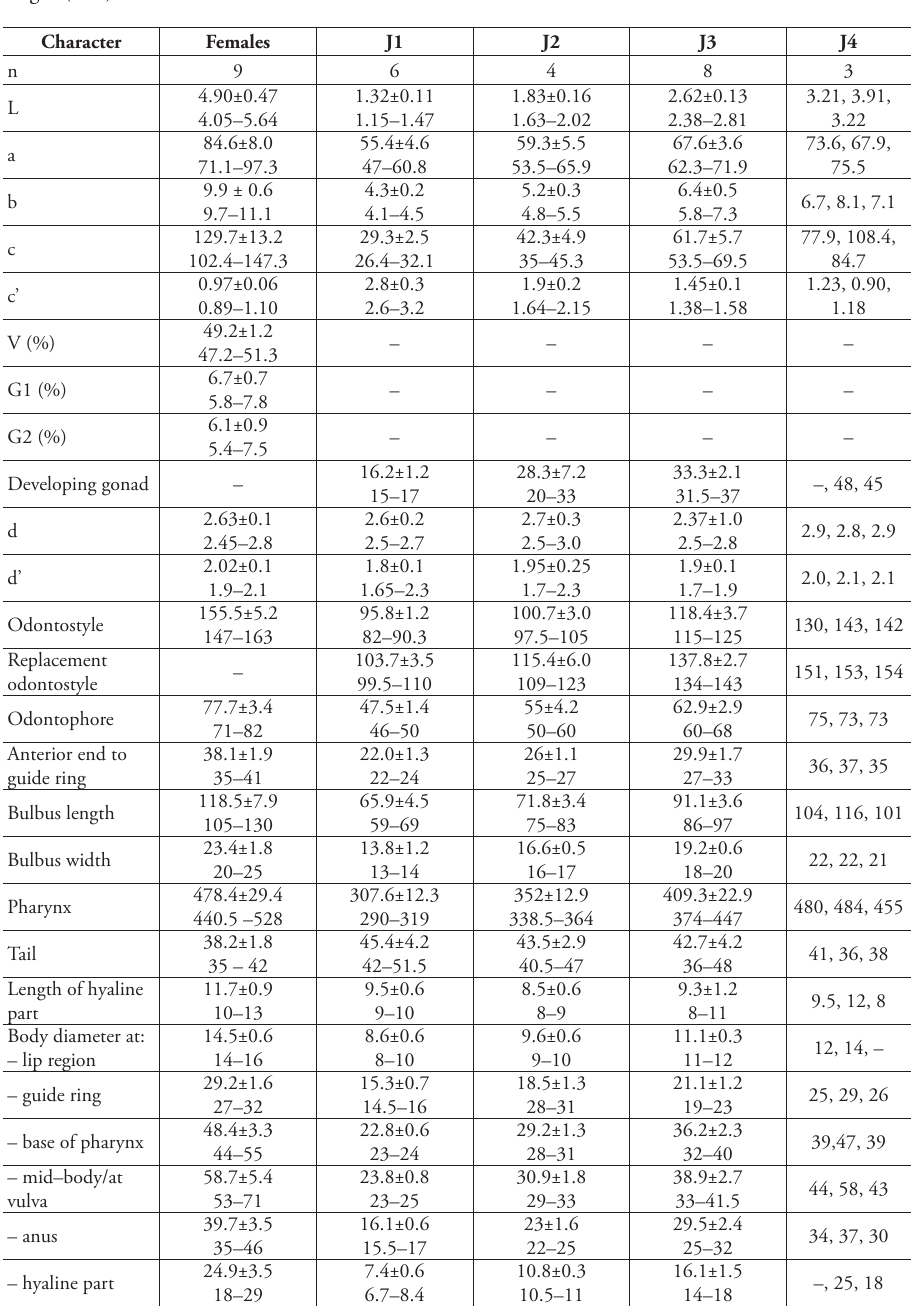
Table 1. Measurements of females and juveniles (J) of Longidorus piceicola from Bran, Braşov County, Romania (mean ± standard deviation, with range). All measurements in micrometers except for body length